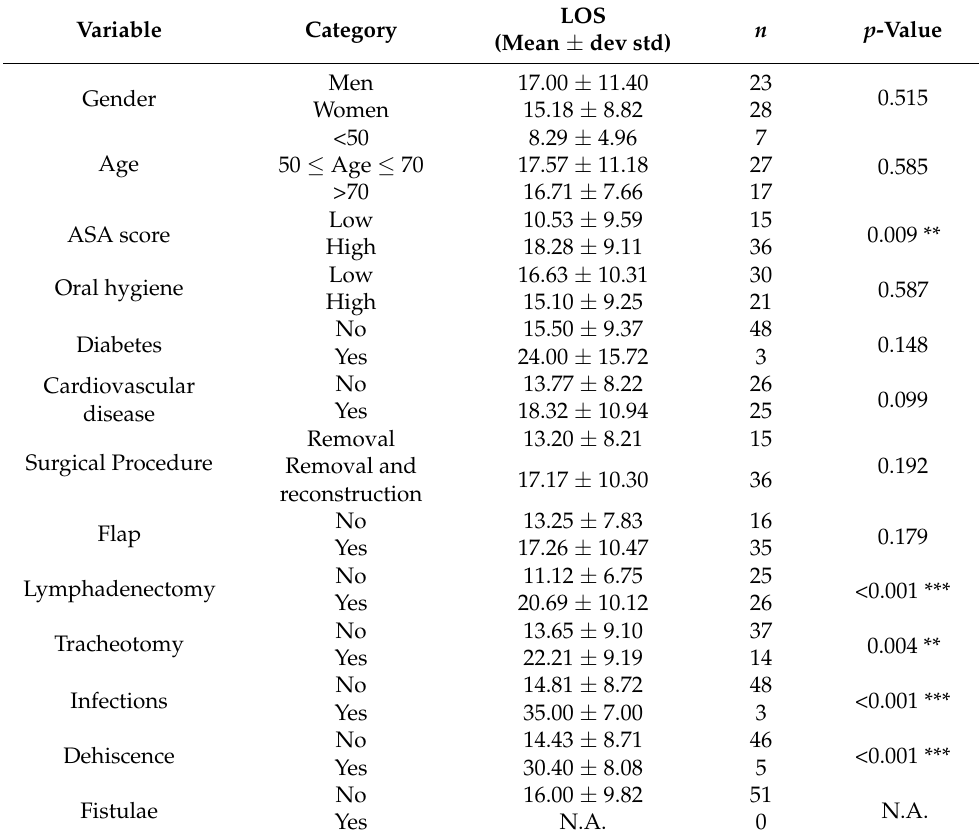
Table 3. Variables influencing LOS for Cefazolin plus Clindamycin have been studied by comparing all the categories related to each variable by applying the Mann–Whitney U/Kruskal–Wallis tests. * Significance at 0.05; ** significance at 0.01; *** significance at